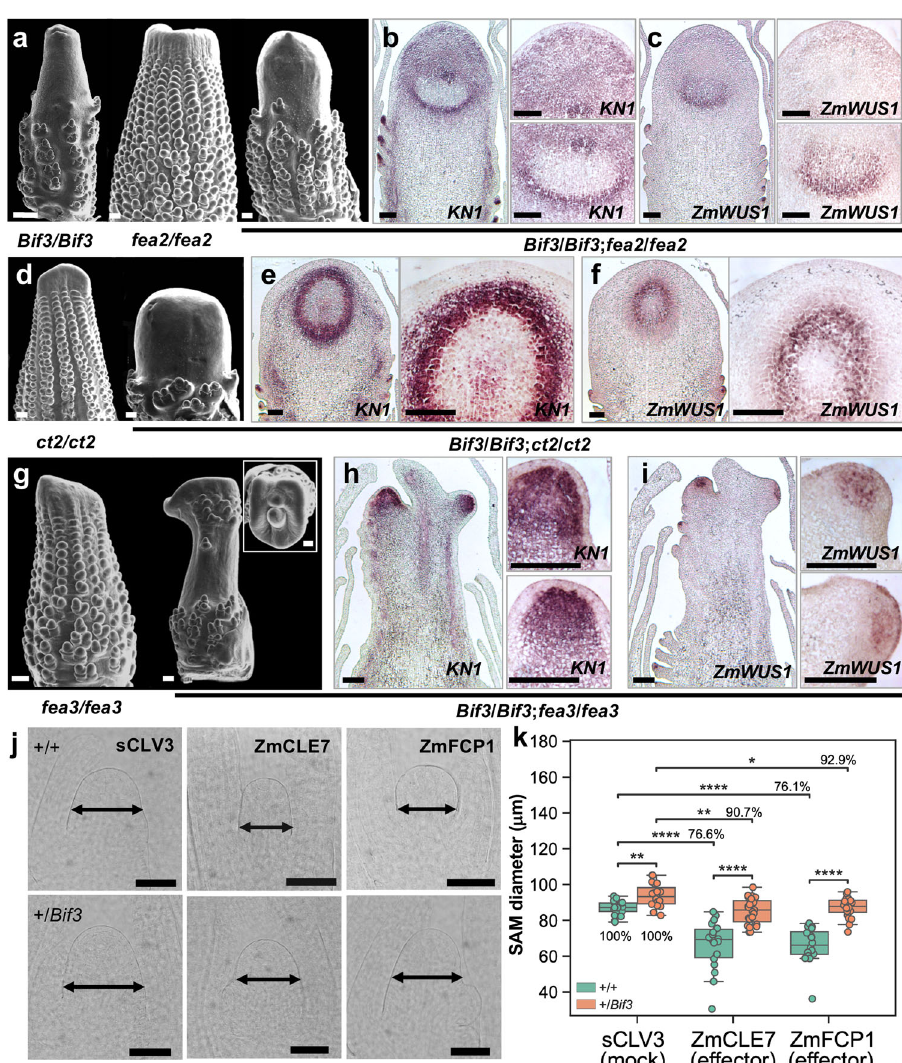
Fig. 6 Genetic and molecular interaction of Bif3 and negative regulators of ZmWUS1 . a , d , g SEMs of single and double mutant ears in B73 background. Scale bars: 200 μ m. b , c , e , f , h , i In situ hybridizations in double mutant immature ears with ZmWUS1 and KN1 antisense probes. Scale bars: 50 μ m. j , k Bif3 SAMs are partially resistant to ZmCLE7 and ZmFCP1 peptide treatments. Percentages in ( k ) indicate reduction relative to scrambled peptide control (sCLV3). Two-tailed Student ’ s t -test * p < 0.05; ** p < 0.01; *** p < 0.001; **** p < 0.0001 ( n + / + sCLV3 = 17; n + /Bif3 sCLV3 = 19; n + / + ZmCLE7 = 18; n + /Bif3 ZmCLE7 = 23; n + / + = 16; n + /Bif3 = 20). Box plot center line, median; box limits, upper and lower quartiles; whiskers, maximum and minimum values. ZmFCP1 ZmFCP1 Single datapoints outside of the whiskers represent outliers Scale bars: 100 μ